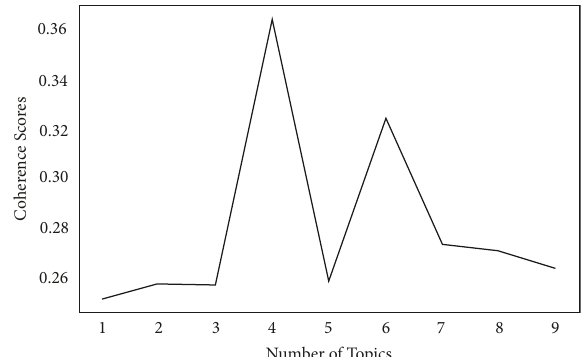
Figure 5: Coherence score of vehicle factors.